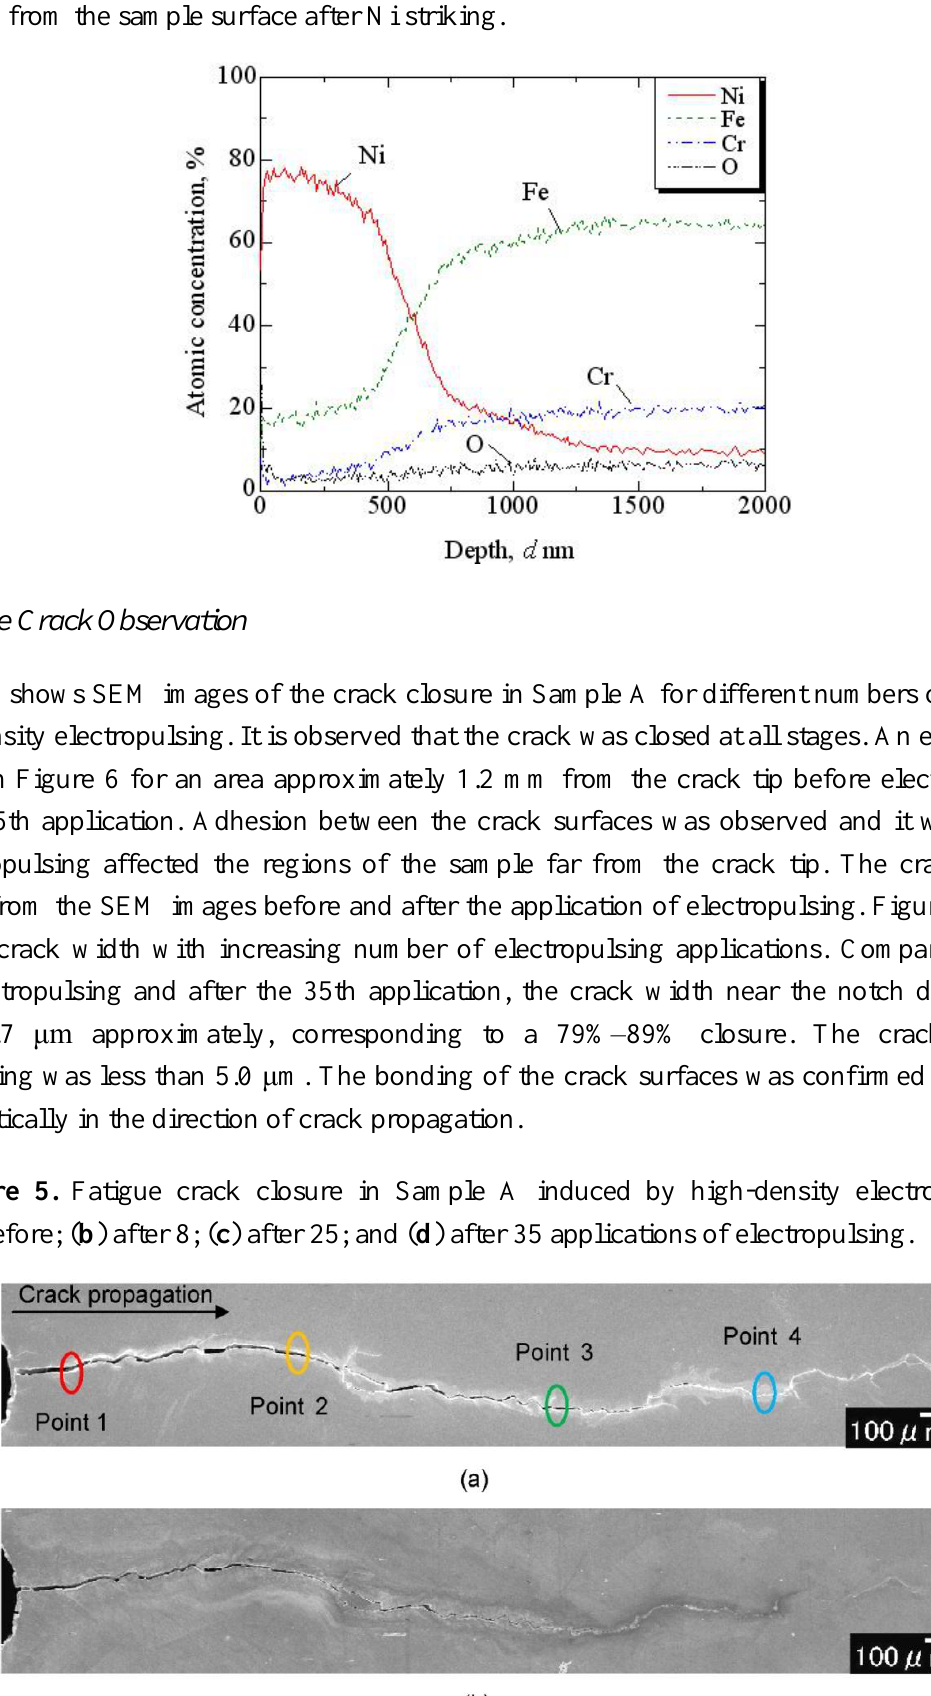
Figure 4. Relationship between the atomic concentrations of O, Cr, Fe and Ni and the depth from the sample surface after Ni striking.